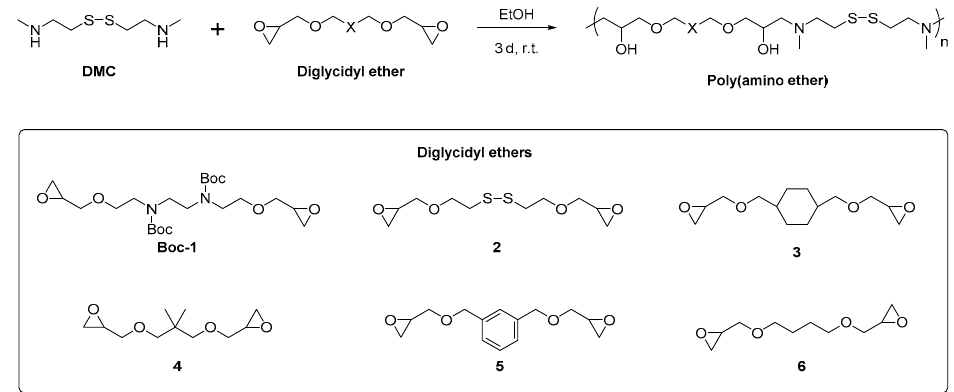
Table 1. Characteristics of linear bioreducible poly(amino ether)s prepared through the reaction of N , N ′ -dimethylcystamine (DMC) with different diglycidyl ethers (1–6). Poly(amino ether)